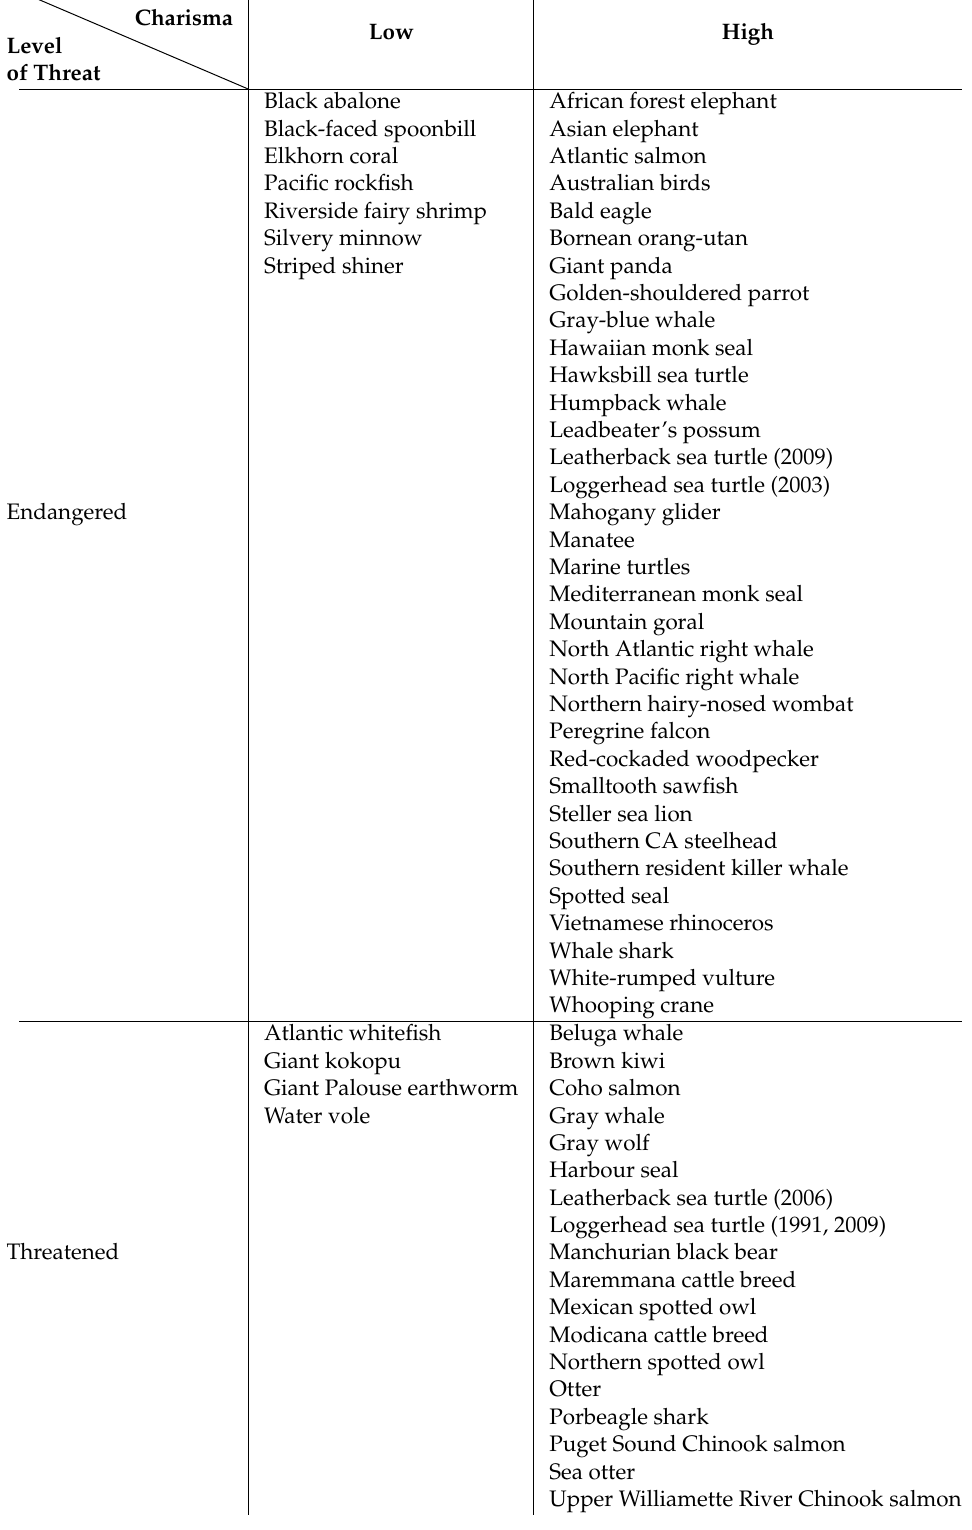
Table A1. Categorisation of species based on the level of threat and